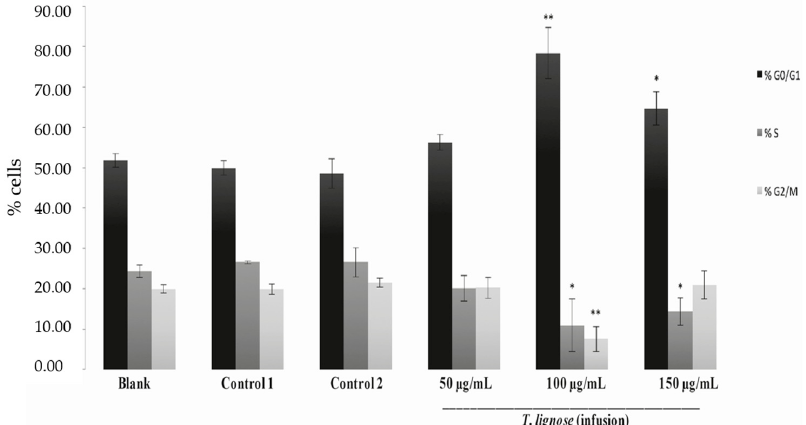
Figure 1. Effect of T. lignosa infusion extract on NCI-H460 cell cycle distribution. Cells were treated for 48 h with complete medium (Blank), with the extract (50 µ g/mL, 100 µ g/mL, or 150 µ g/mL), or with Control treatments (the two highest vehicle, H 2 O, concentrations). Results are the mean ± SEM of four independent experiments. * p ≤ 0.05 and ** p ≤ 0.01 Blank vs. Treatment.